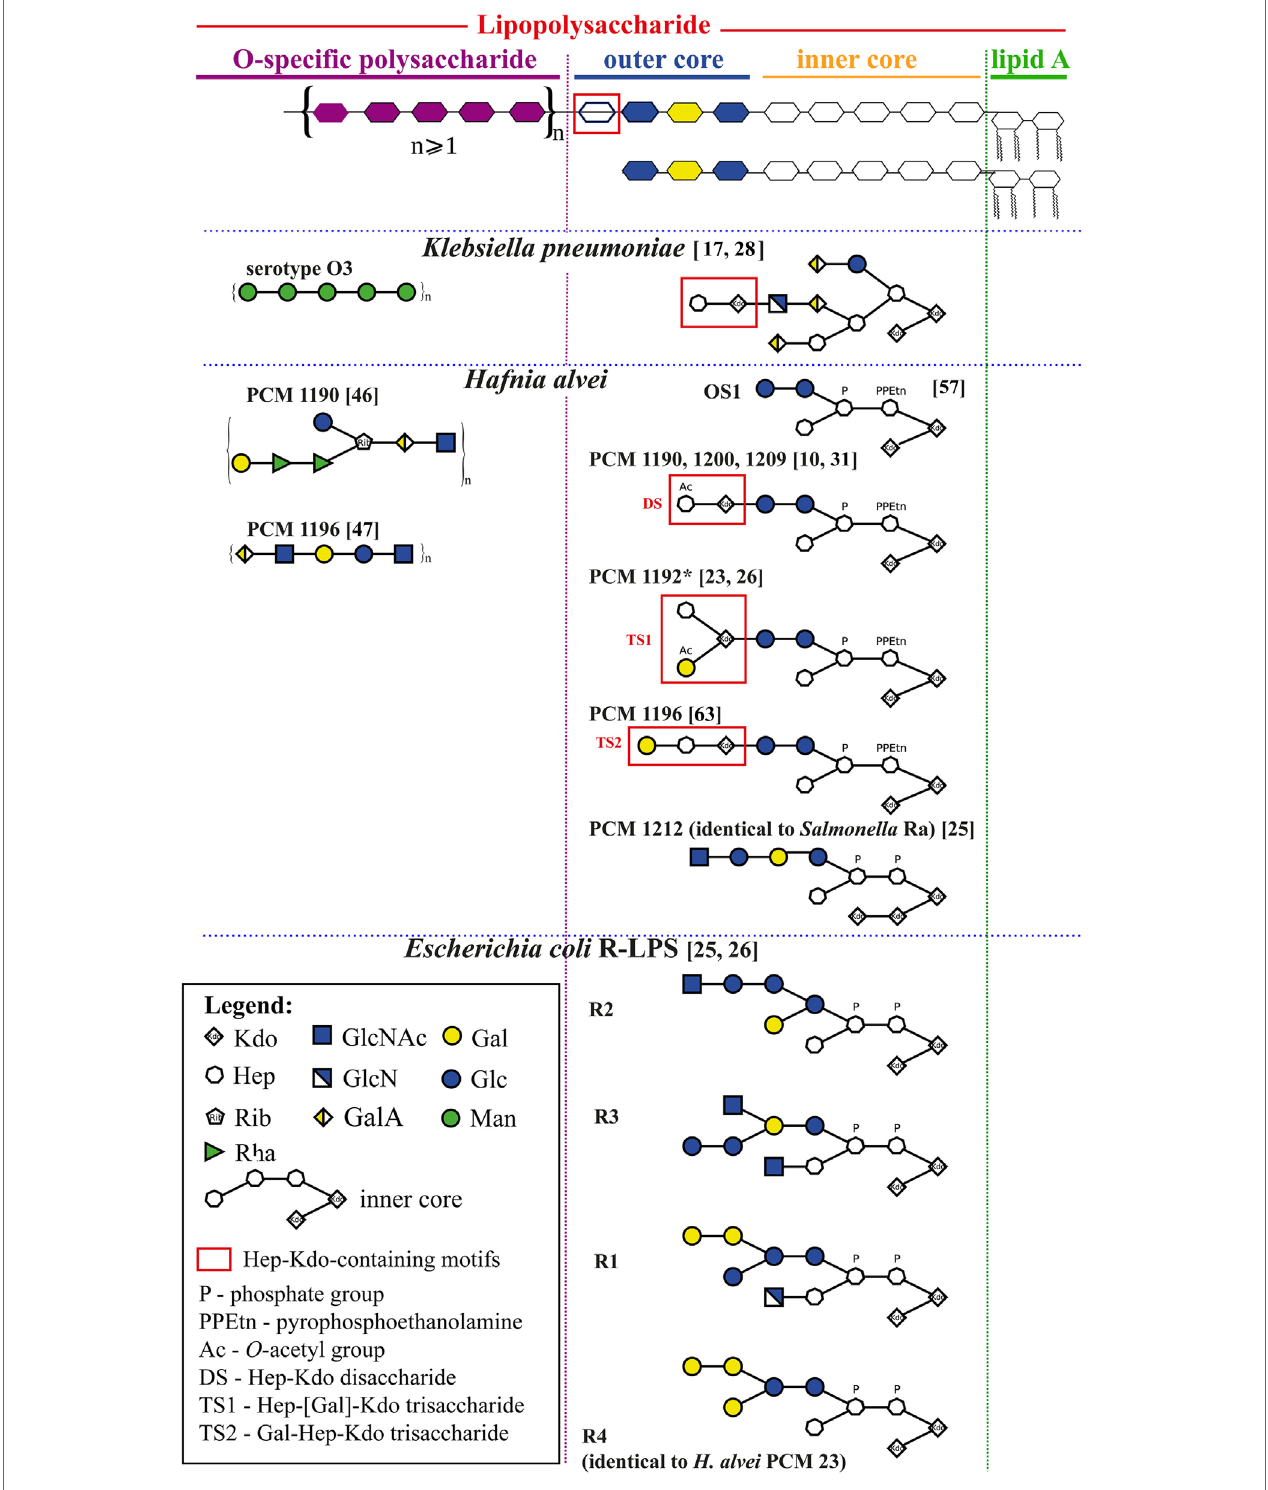
FigUre 1 | Schematic structures of selected Klebsiella pneumoniae , Hafnia alvei , and E. coli , and Salmonella spp. lipopolysaccharides (LPSs) relevant for an interpretation of human mannose-binding lectin–LPS interactions. All structures are grouped according to the schematic diagram of an LPS molecule (upper panel) built of lipid A, core oligosaccharide (inner and outer), and O-specific polysaccharide consisting of a varying number of oligosaccharide repeating units. Information about linkages and isomers was hidden to simplify an interpretation of structures and may be found in details in references (numbers in